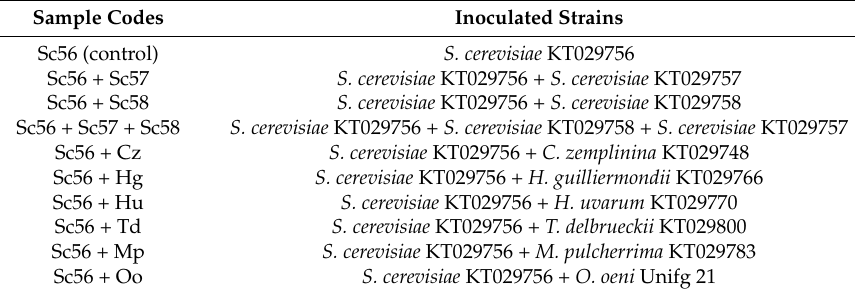
Table 1. Microorganisms employed in the different grape must